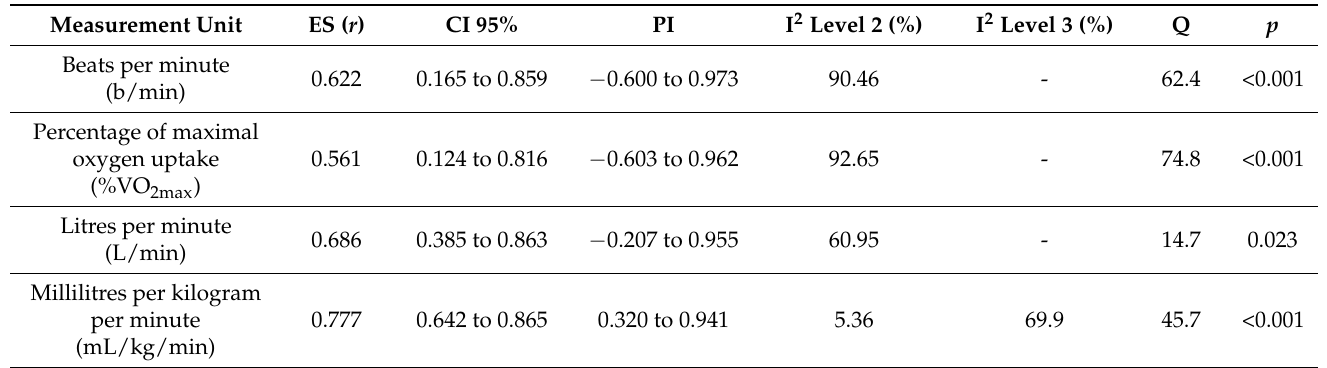
Table 2. Descriptive statistics of pooled ESs according to measurement